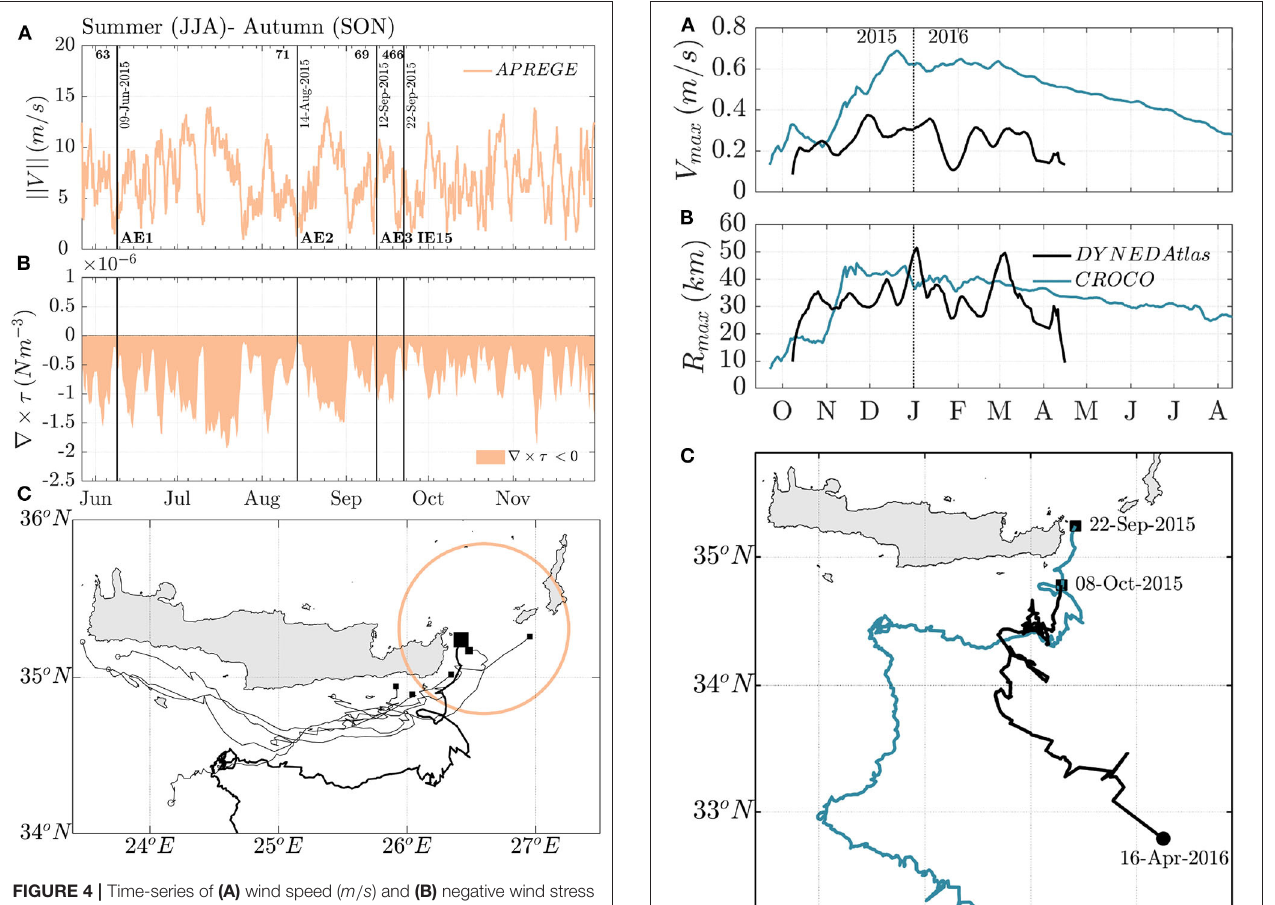
FIGURE 4 | Time-series of (A) wind speed ( m / s ) and (B) negative wind stress curl h∇ × τ i are shown with the orange color as extracted from ARPEGE wind data. The selected area for analyzing the wind forcing climatology is illustrated with the orange circle in (C) . Trajectories of long-lived ( > 2 weeks) eddies (gray colors) detected in CROCO model in the southeastern lee of Crete island during the summer and autumn of 2015. The first points of the eddy detection are plotted with the black square points while the points of last detection are illustrated with the open white circles. The longest-lived detected anticyclone is illustrated with the thick black line.